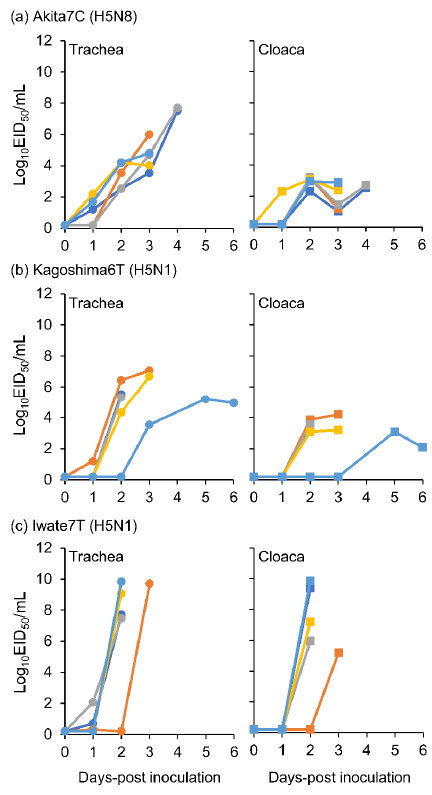
Figure 2. Viral titers in each tracheal and cloacal swab collected from chickens inoculated with the 10 6 EID 50 of ( a ) Akita7C, ( b ) Kagoshima6T, and ( c ) Iwate7T strains. Viral titers in tracheal and cloacal swabs are represented by circles and squares (blue, light blue, orange, yellow, and gray), respec ‐ tively.